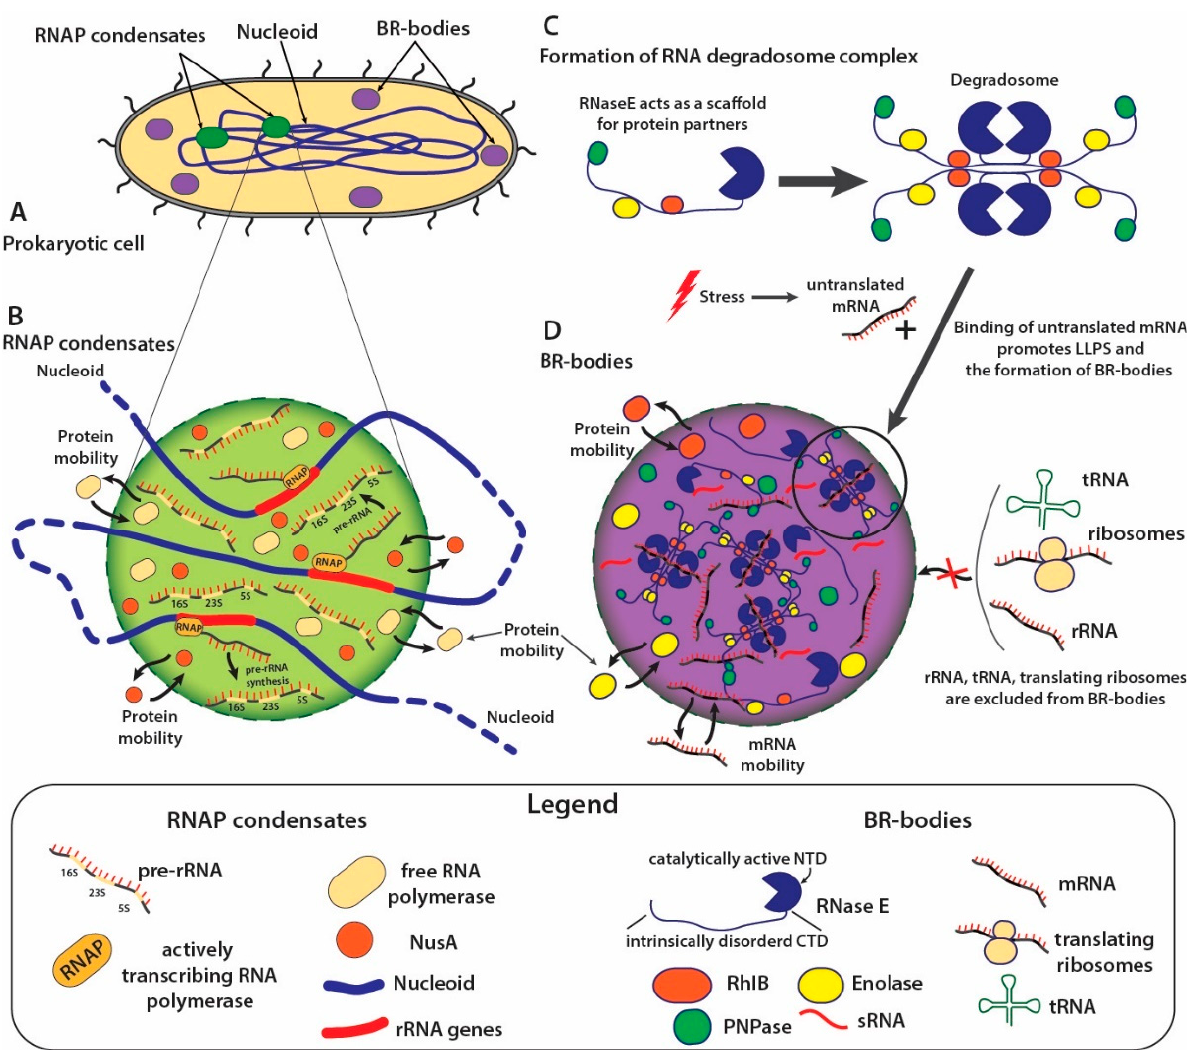
Figure 2. Schematic representation of RNAP condensates and BR-bodies formation in prokaryotic cells. ( A ) . Prokaryotic cell with depicted relative localizations of nucleoid, RNAP condensates (green) and BR-bodies (violet). ( B ) . RNAP condensates form via LLPS at the rRNA operons of nucleoid. They are associated with active